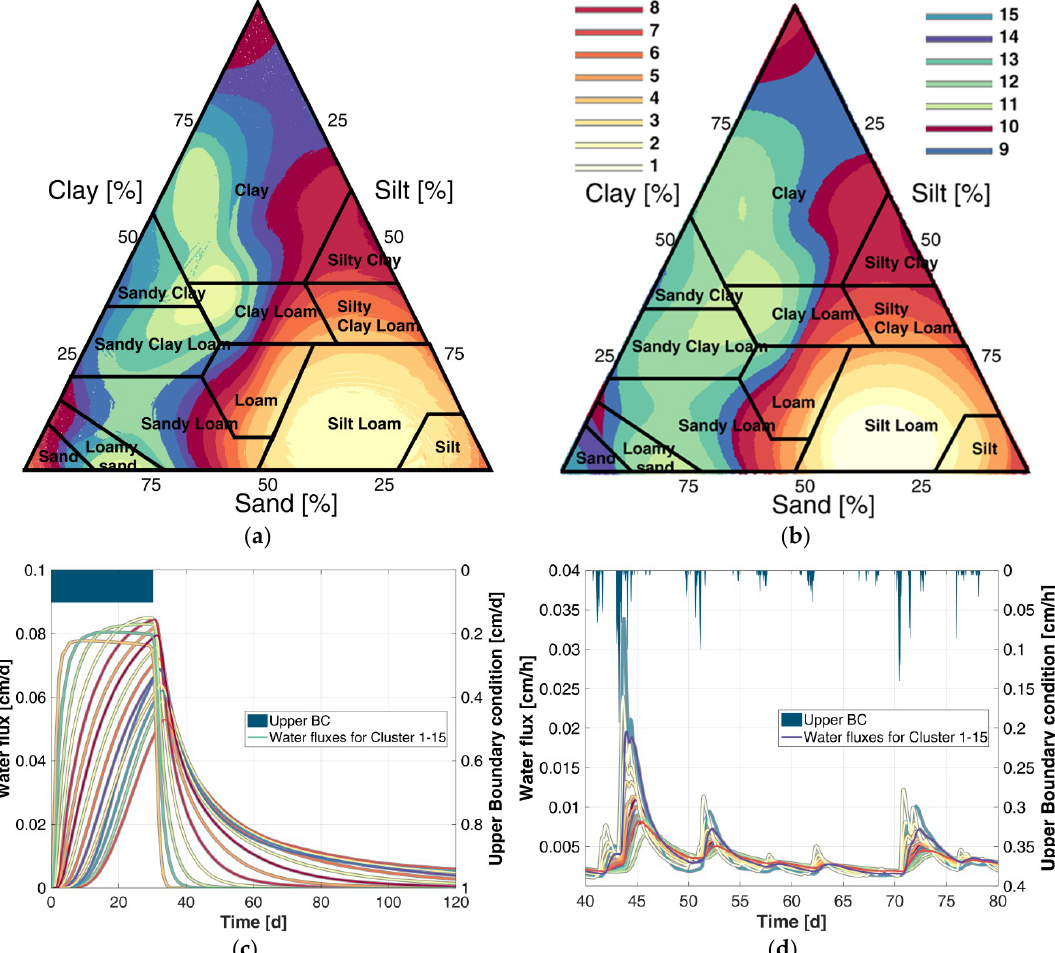
Figure 3 . ( a ), ( b ): Texture triangle with classification results for 15 classes (coloured patterns) based on hydraulic response in comparison to the established United States Department of Agriculture (USDA) classification [8]. ( a ): Impulse boundary condition (IBC); ( b ): Dynamic boundary condition (DBC). ( c ), ( d ): Representative time series of water flux for the 15 classes based on IBC ( c ) and DBC ( d ). The legend numbering is in consistence with Table 1.